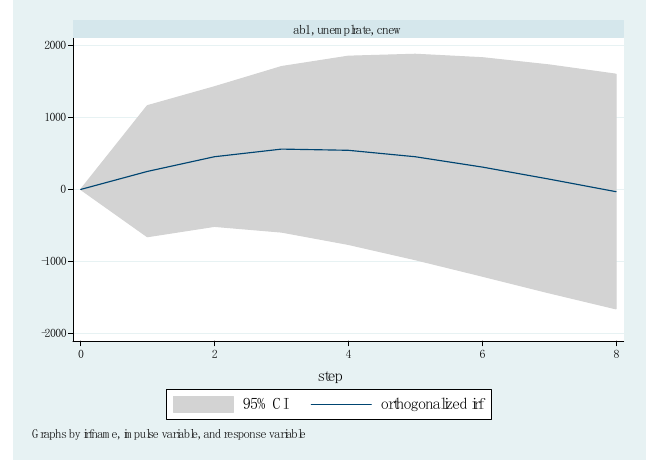
Figure 9. Impulse in the form of a logarithm of salaries growth and a response in the form of a logarithm of new loans growth.